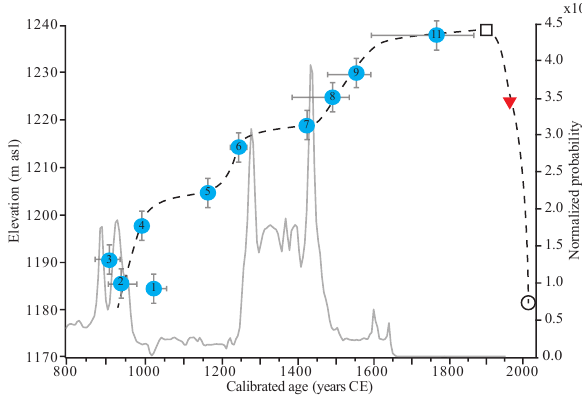
Figure 3. Plot of transect radiocarbon ages with elevation, showing median age (dots with sample numbers) and 1 σ uncertainty and ver- tical GPS uncertainty (gray bars). Position of ∼ 1900CE Neoglacial maximum extent (square) also shown. The position of the DIC mar- gin interpreted from 1960 aerial photography is shown (triangle), as well as its observed 2015 position (circle). The inferred ice mar- gin history (dashed line) plotted through samples ages illustrates the episodic nature of ice margin advance. The episodic nature of DIC expansion agrees well with the normalized probability compilation of recently exposed ice margin in situ plant ages from Baffin Island (gray line), which shows periods of regional ice expansion